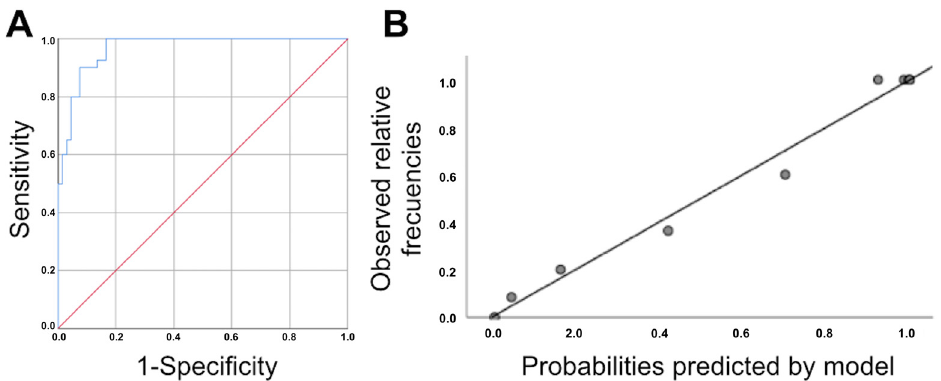
Figure 2. ( A ): ROC curve for the logistic regression model obtained from the association between the difference in the pubis–uterine fundus distance at rest and with the Valsalva maneuver and age. Area under the ROC curve: 0.967 (95% CI, 0.939–0.995; p < 0.0005). ( B ): Calibration graph of original logistic regression model obtained for the association between the difference in the pubis–uterine fundus distance at rest and with the Valsalva maneuver and age.